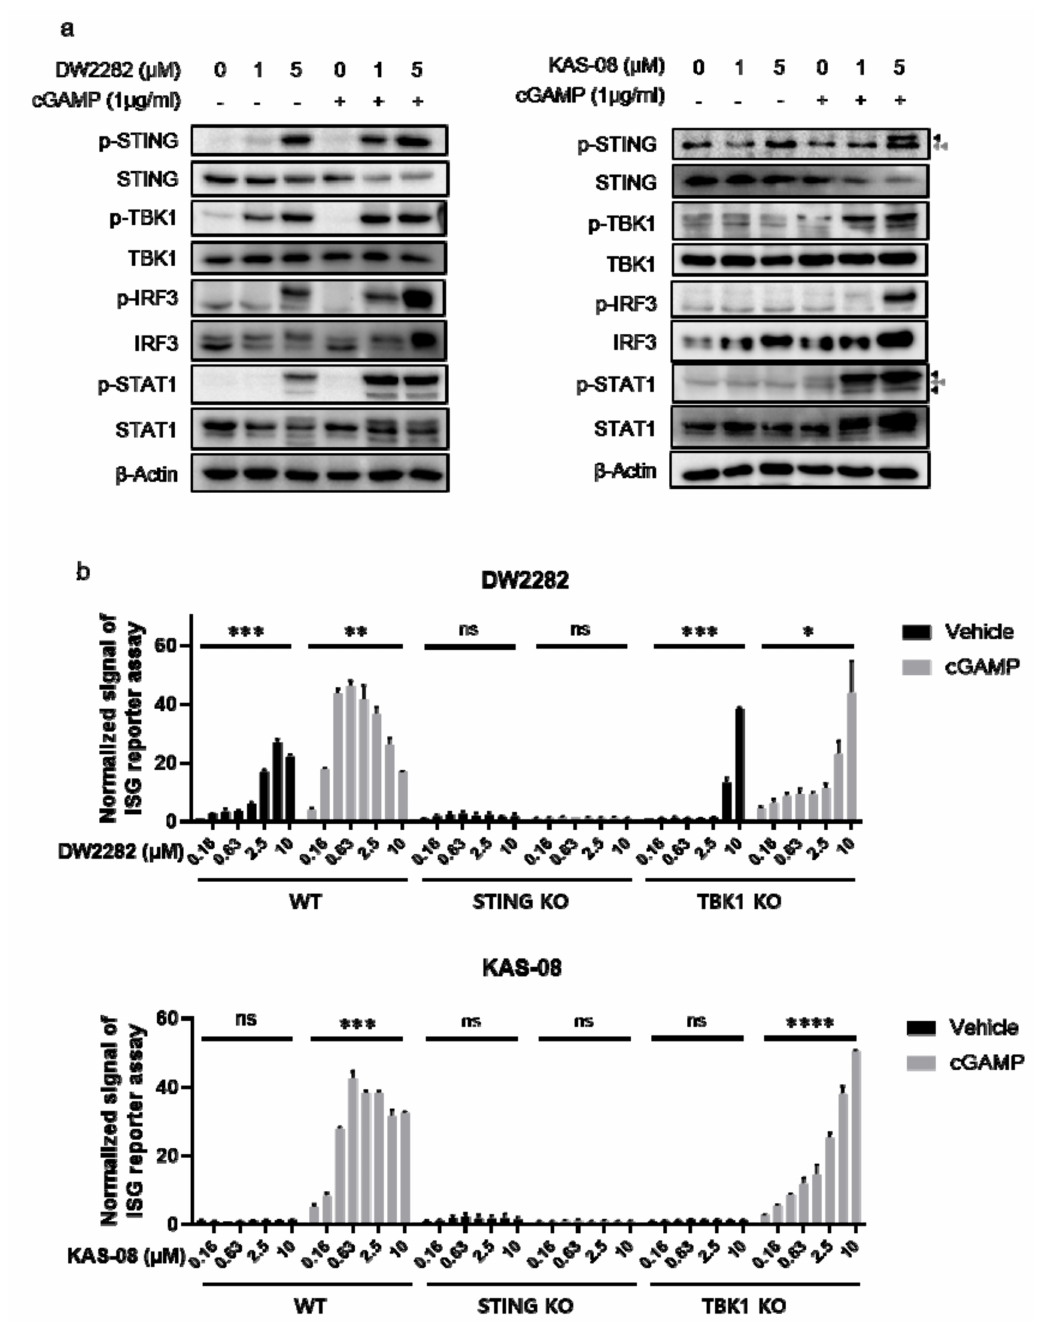
Figure 5. Analysis of the signaling pathway for cGAMP-mediated STING activation by DW2282 and KAS-08. ( a ) Western blot analysis for STING signaling pathway. Both DW2282 and KAS-08 were treated in THP-1 cells for 6 h in the absence or presence of cGAMP (1 µ g/mL) stimulation. Black arrowheads indicate p-STING or p-STAT1 and gray double-arrowheads indicate non-specific band. ( b ) ISG reporter assay of DW2282 ( up ) and KAS-08 ( down ) in THP-1 WT, STING KO, and TBK1 KO cells. DW2282 and KAS-08 were treated in the range from 10 µ M to 160 nM in the absence or presence of cGAMP (1 µ g/mL). Luciferase signal was normalized by DMSO control. Graphs show the mean and SD. *: p < 0.05, **: p < 0.01, ***: p < 0.001, ****: p < 0.0001 and ns: non-significant by Student’s t